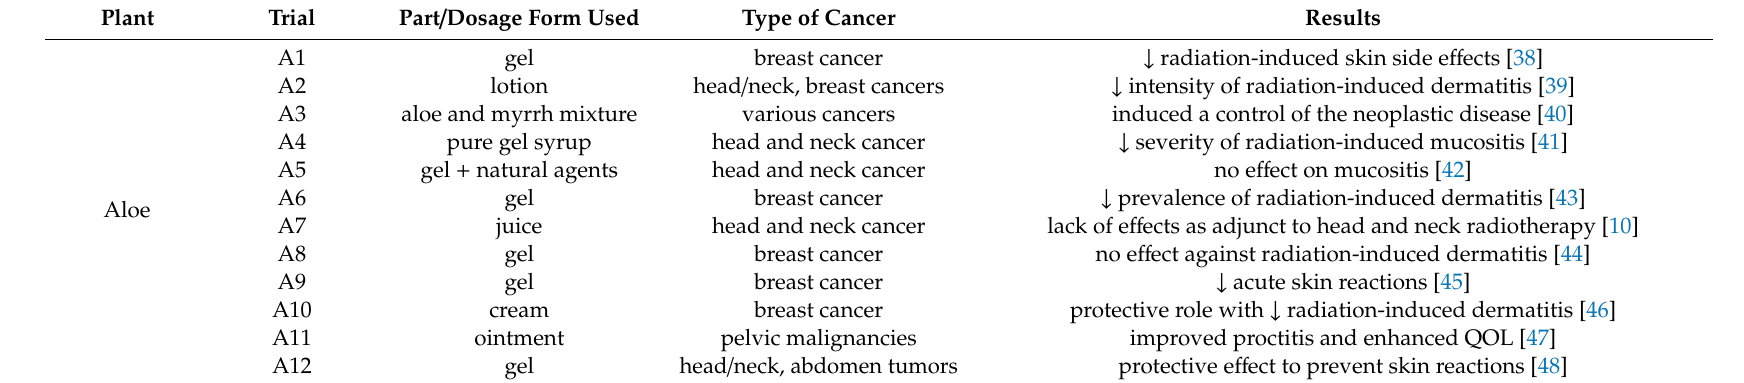
Table 2. Clinical trials in cancer for the selected herbs with details about type of cancer and its outcome